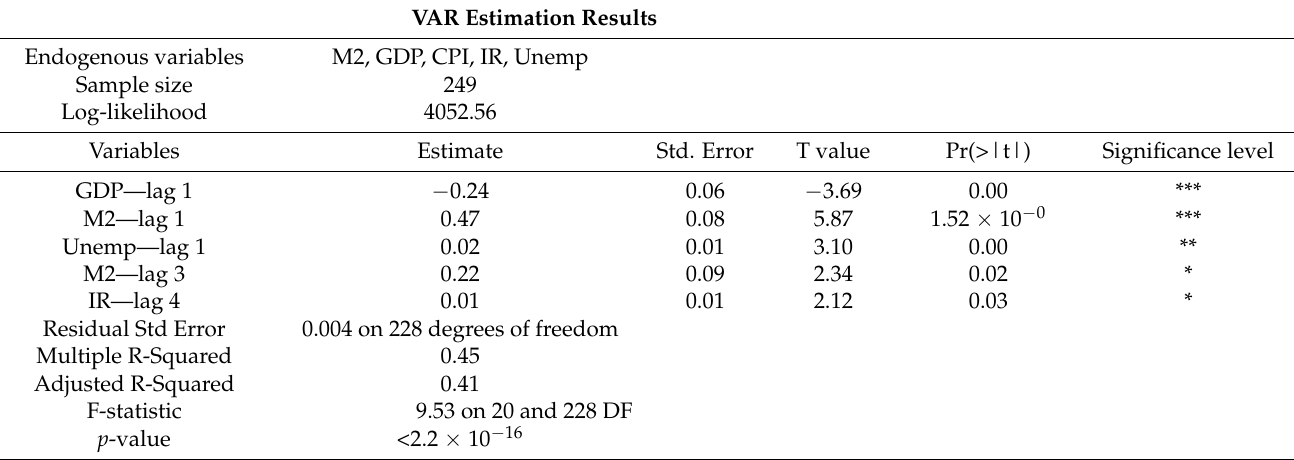
Table 6. The VAR estimation of Money Supply (M2). VAR Estimation